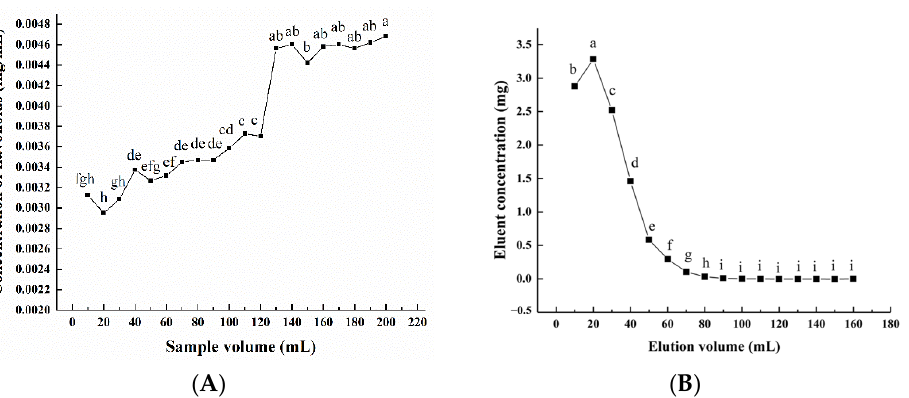
Figure 3. Effect of sample volume ( A ) and elution volume ( B ) on the desorption rate of macroporous resin. Experiments were performed in triplicate, and data are expressed as the mean ± SE. Different lowercase superscript letters denote statistically significant differences ( p < 0.05).